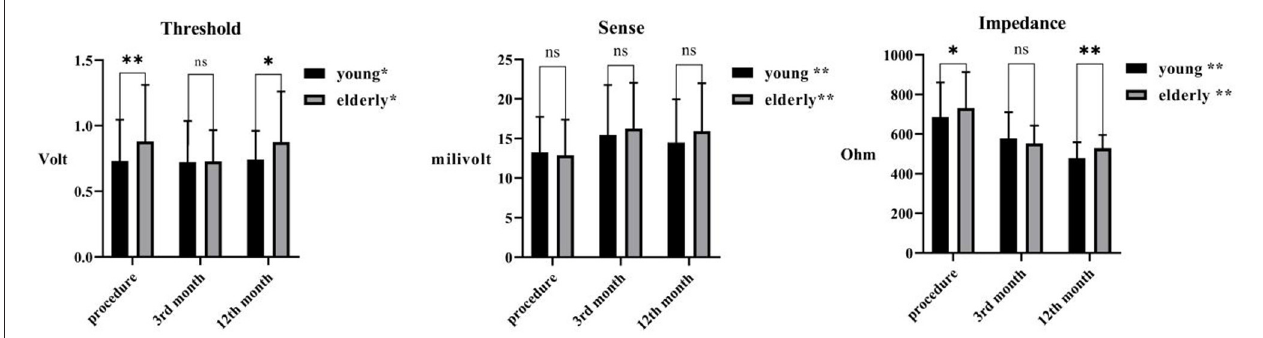
FIGURE 3 | Pacing parameters during LBBP in the 3rd and 12th month after implantation between young and elderly groups. * and ** indicates statistical significance, p < 0.05 and 0.01, respectively, and ns denotes non-significance.